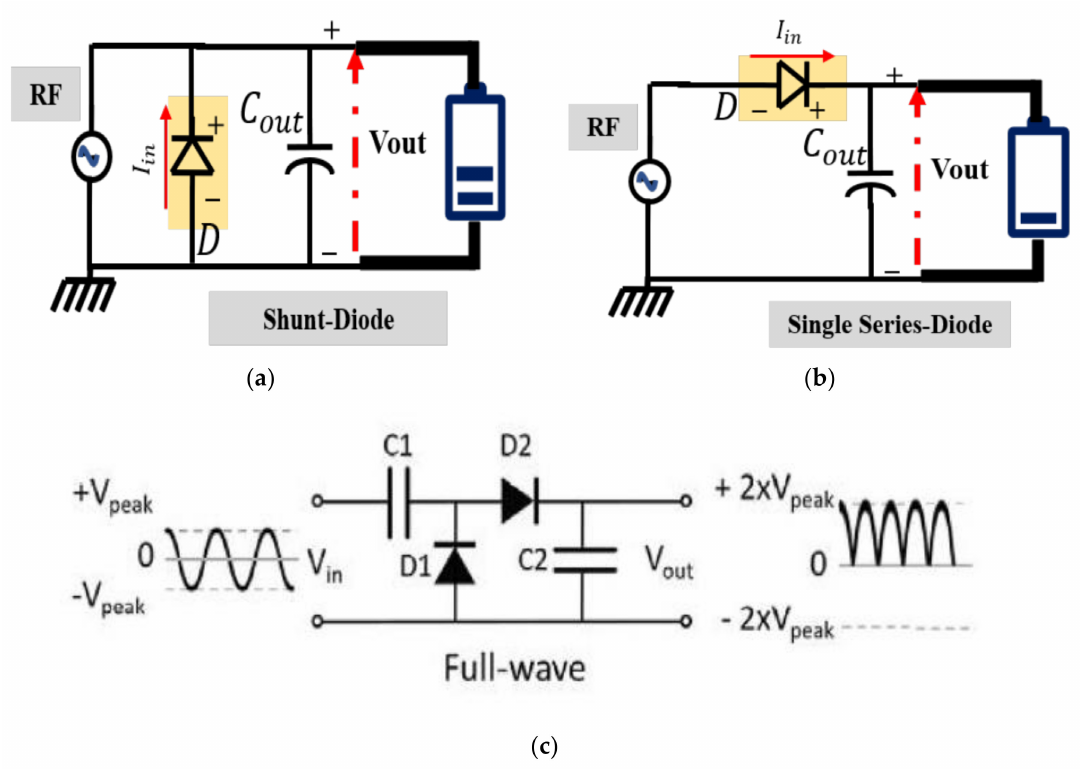
Figure 3. Half-wave rectifier with ( a ) shunt configuration and ( b ) series configuration [140], and ( c ) full-wave rectifier configuration